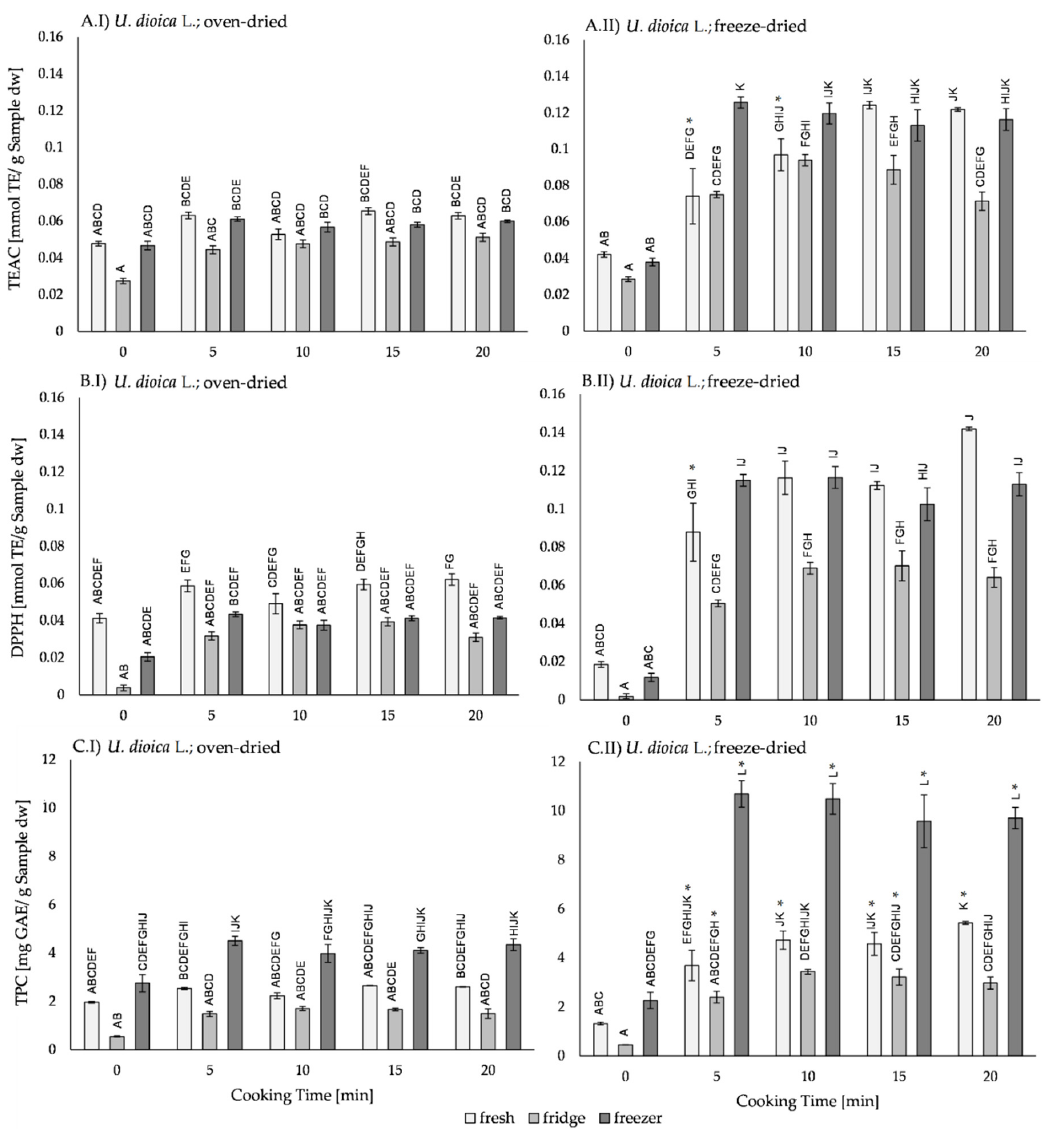
Figure 3. Antioxidant activity of (I) oven-dried and (II) freeze-dried uncooked (0 min) and cooked (5, 10, 15, and 20 min) Urtica dioica L. samples measured by ( A ) TEAC-, ( B ) DPPH-, and ( C ) TPC assays. Fresh samples (light grey) and samples stored after cooking in the fridge (7 ◦ C for 3 days; medium grey) or in the freezer ( − 20 ◦ C for 30 days; dark grey) were compared. Bars represent mean ± standard error (SE). Significant differences ( p ≤ 0.05 by Tukey’s HSD test) are marked with uppercase letters. Differences between samples with and without addition of 5-caffeoylquinic acid are marked with an asterisk